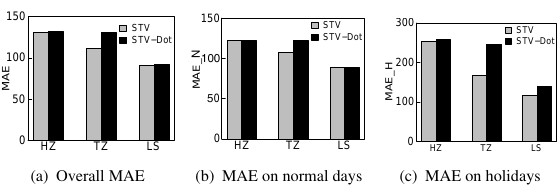
Fig. 8 MAE comparison of STV and STV-NTV.